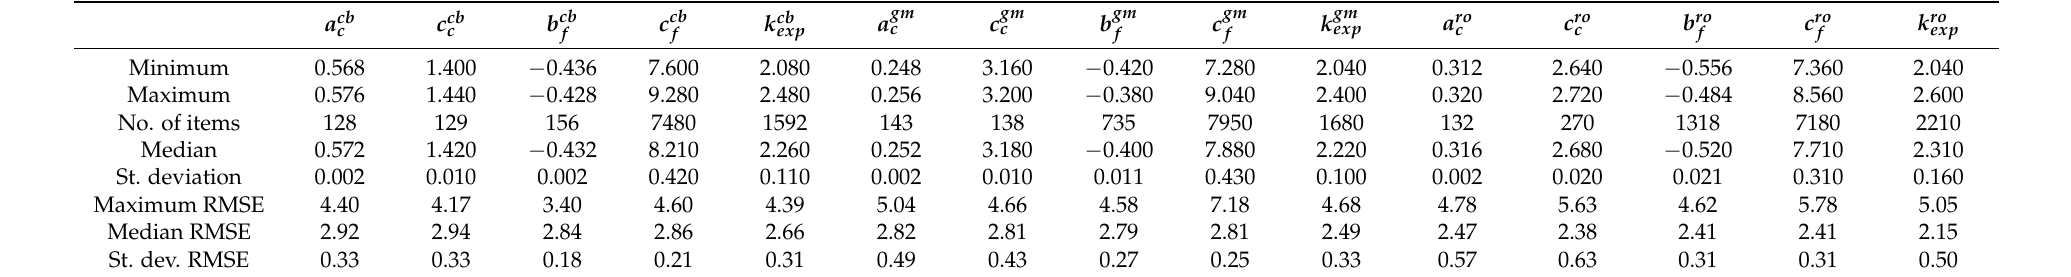
Table 3. Characterization of the local optimum parameter vectors of the unified model: the minimum and maximum values of the bins with significantly higher number of optimized limit values (optimum bins), the number of the limits in them, the median and the standard deviation, together with the maximum, the median, and standard deviation of the RMSE. The values belonging to the cultivars ‘Cegl é di b í borkajszi’, ‘Gönci magyar kajszi’, and ‘R ó zsakajszi C.1406’ are denoted by the superscripts ‘cb’, ‘gm’, and ‘ro’